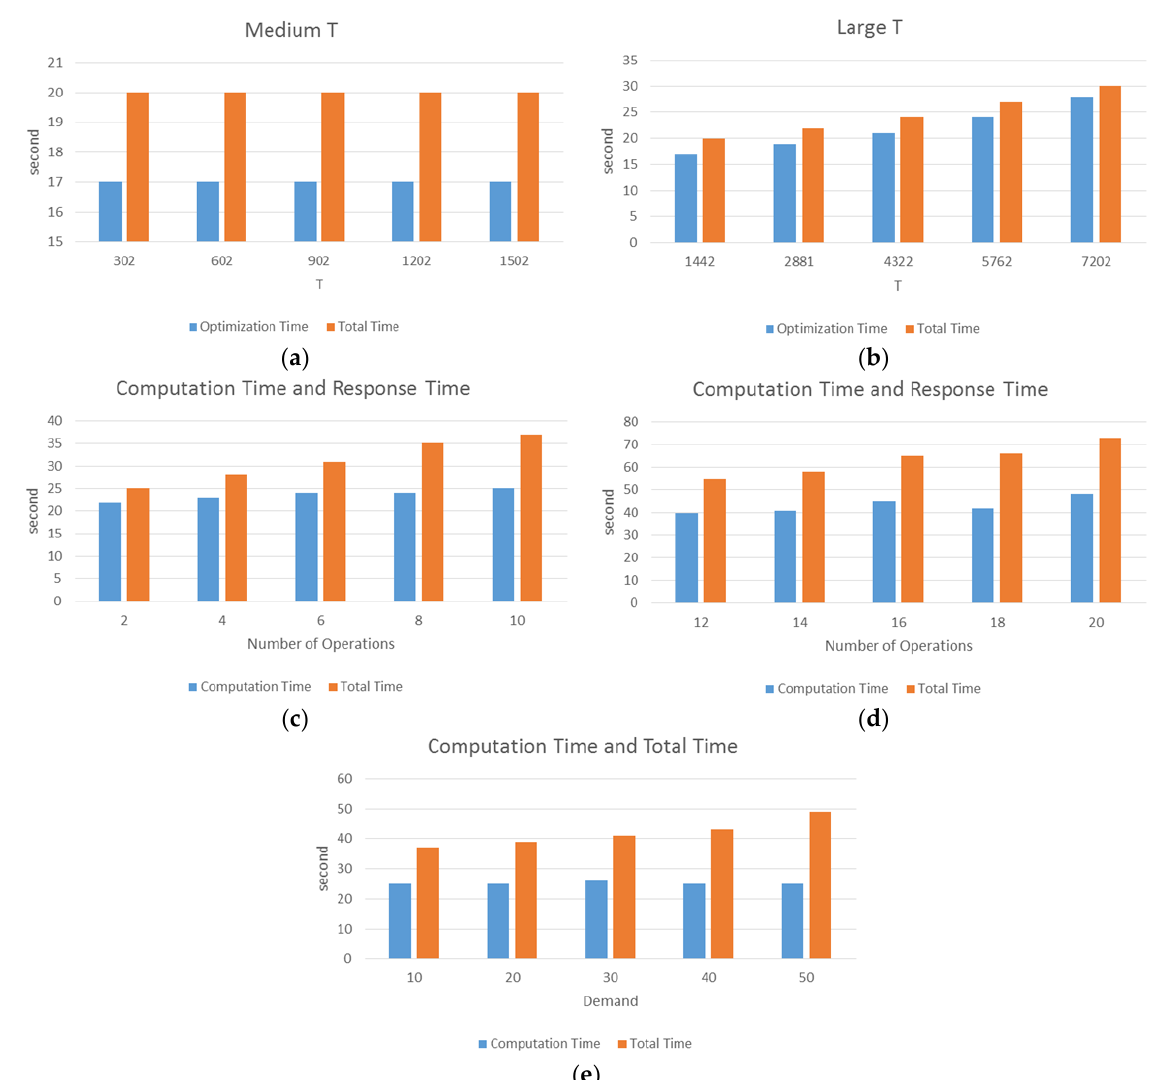
Figure 13. ( a ) Influence of time horizon T on computation time and the total response time for medium time horizon; ( b ) influence of time horizon T on computation time and the total response time for large time horizon; ( c ) influence of the number of operations on computation time and the total response time by changing the number of operations from 2 to 10; ( d ) influence of the number of operations on computation time and the total response time by changing the number of operations from 12 to 20; ( e ) Influence of demand on computation time and the total response time by changing the demand from 10 to 50.